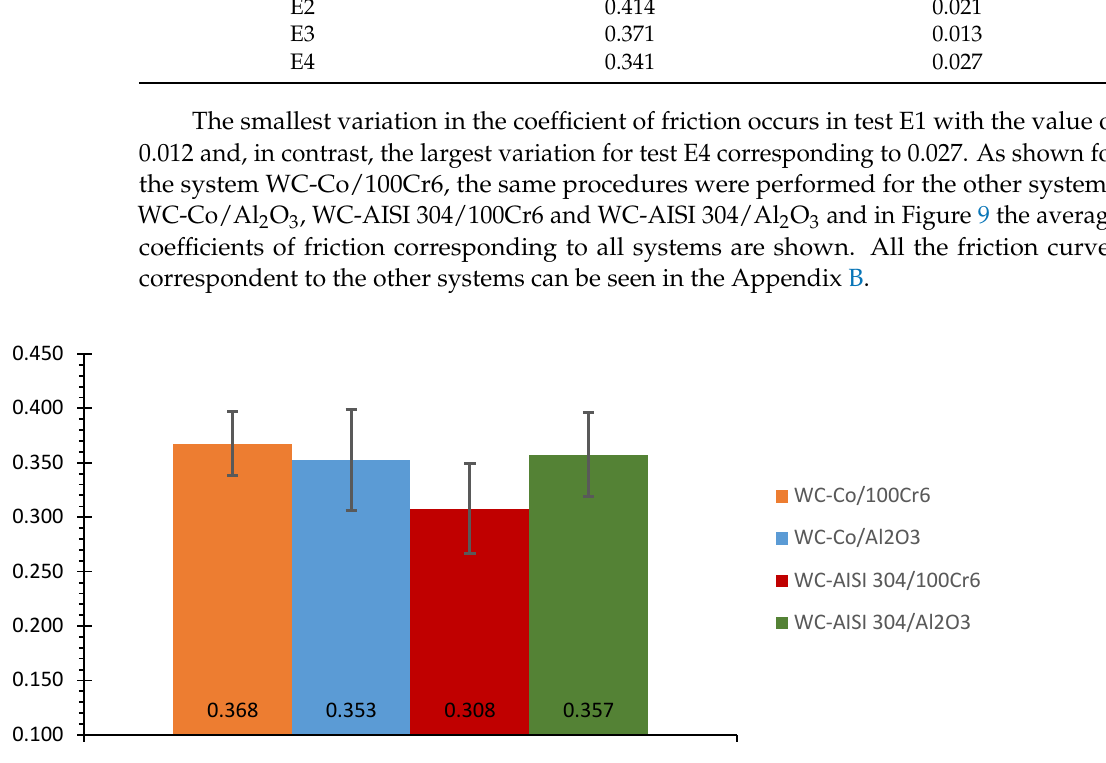
Figure 9. Average coefficient of friction and variation of the average coefficient of friction for the systems: WC-Co/100Cr6, WC-Co/Al 2 O 3 , WC-AISI 304/100Cr6 and WC-AISI 304/Al 2 O 3 .